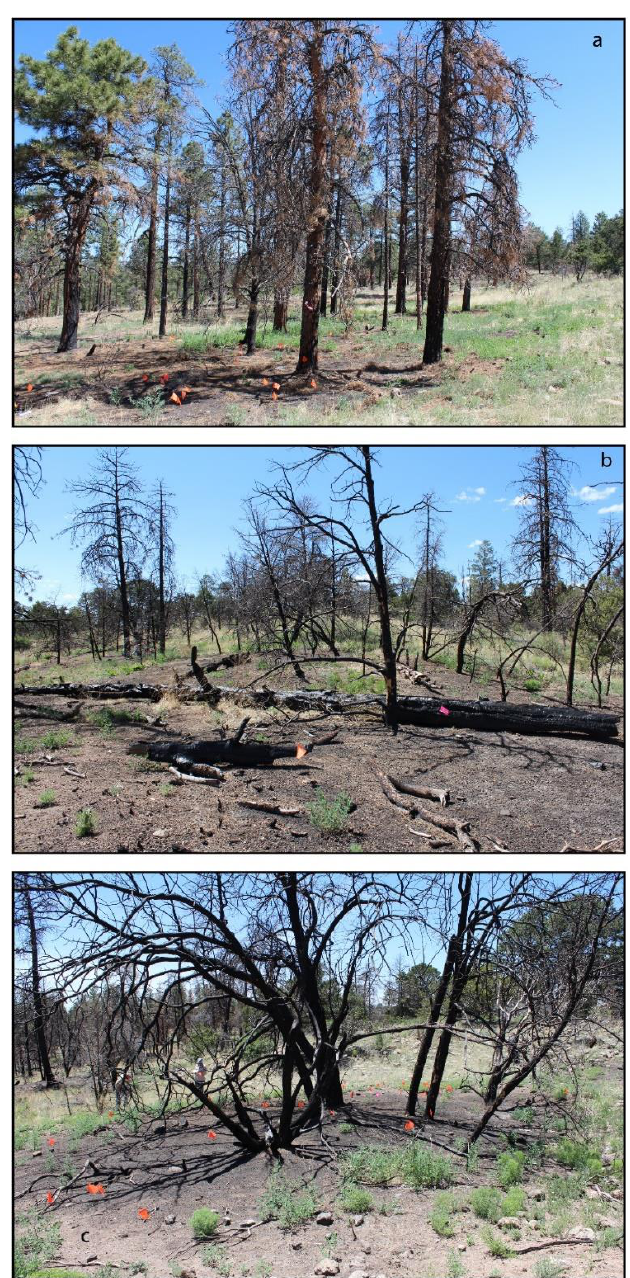
Figure A1. Context photos of ceramic collection locations in the 2012 burn area. Orange and pink flags indicate the location of ceramic samples. ( a ) Surface fire with crown scorch (HS samples); ( b ) surface fire with heavy fuels / logs (HL samples); ( c ) crown and surface fire under pinyon pines (HC samples). (Photos by C. Roos.)